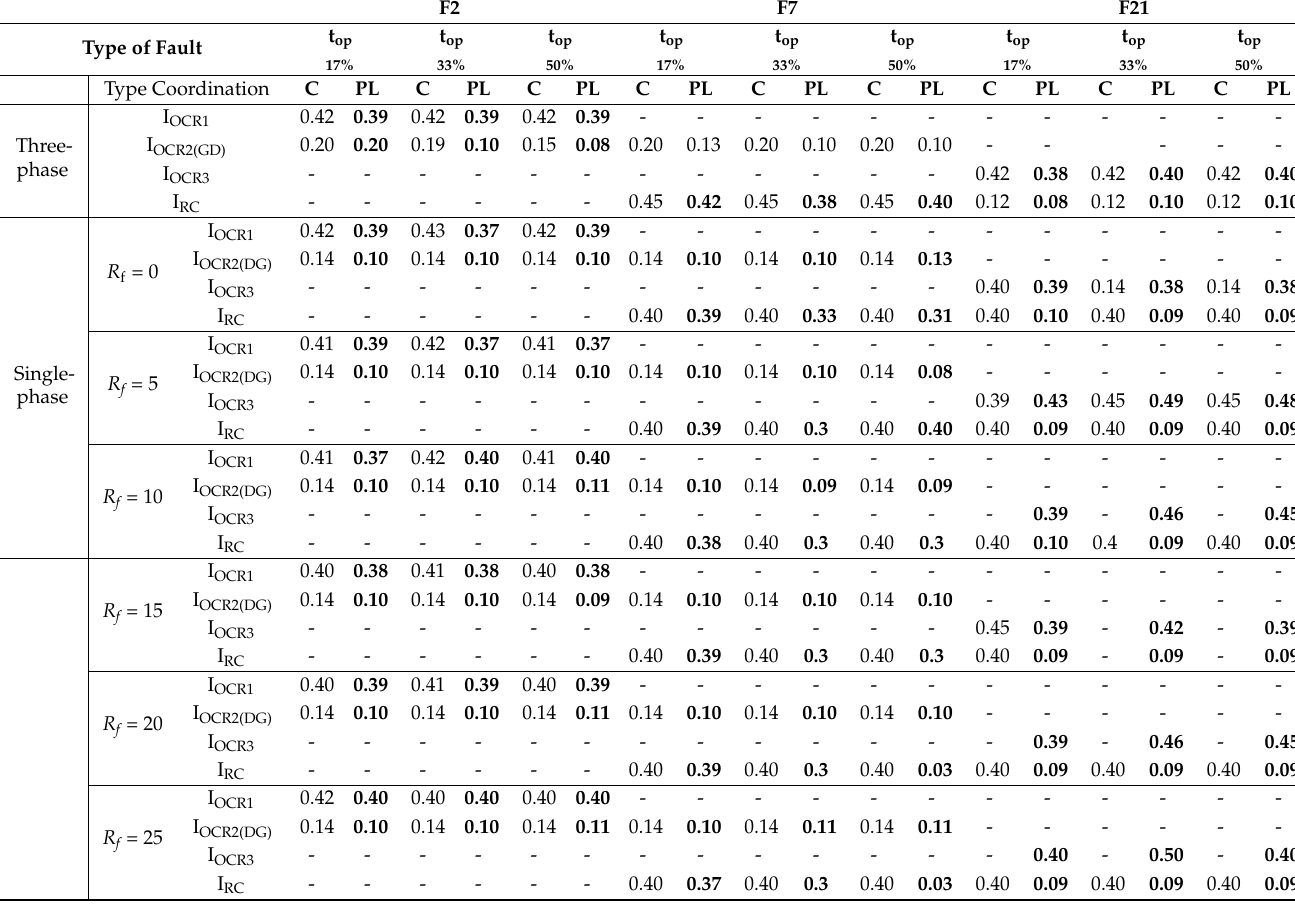
C—classical coordination; PL —lineal programming